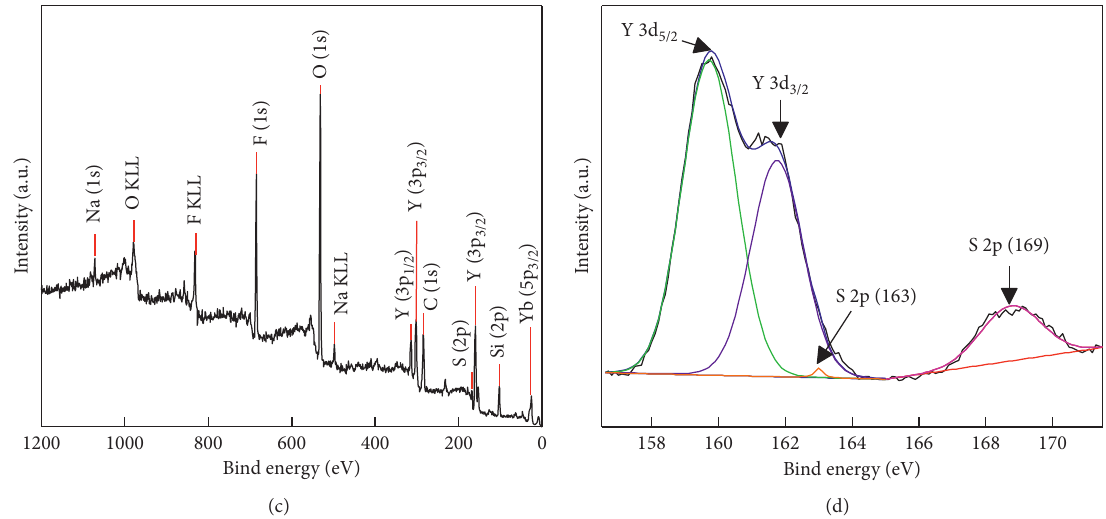
Figure 3: (a) TEM images of SO 3 -SiO 2 @DCNPs. (b) FT-IR spectrums of DCNPS and modified nanoparticles. (c) XPS survey spectra of SO 3 - SiO 2 @DCNPs. (d) Deconvolution of S 2p peak of the SO 3 -SiO 2 @DCNPs.